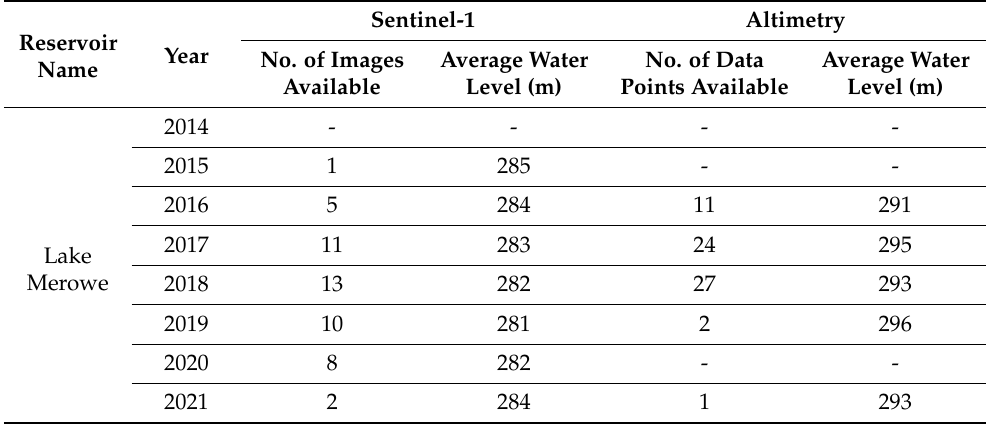
Table 2. Average water levels derived from the two sources for Lake Merowe.